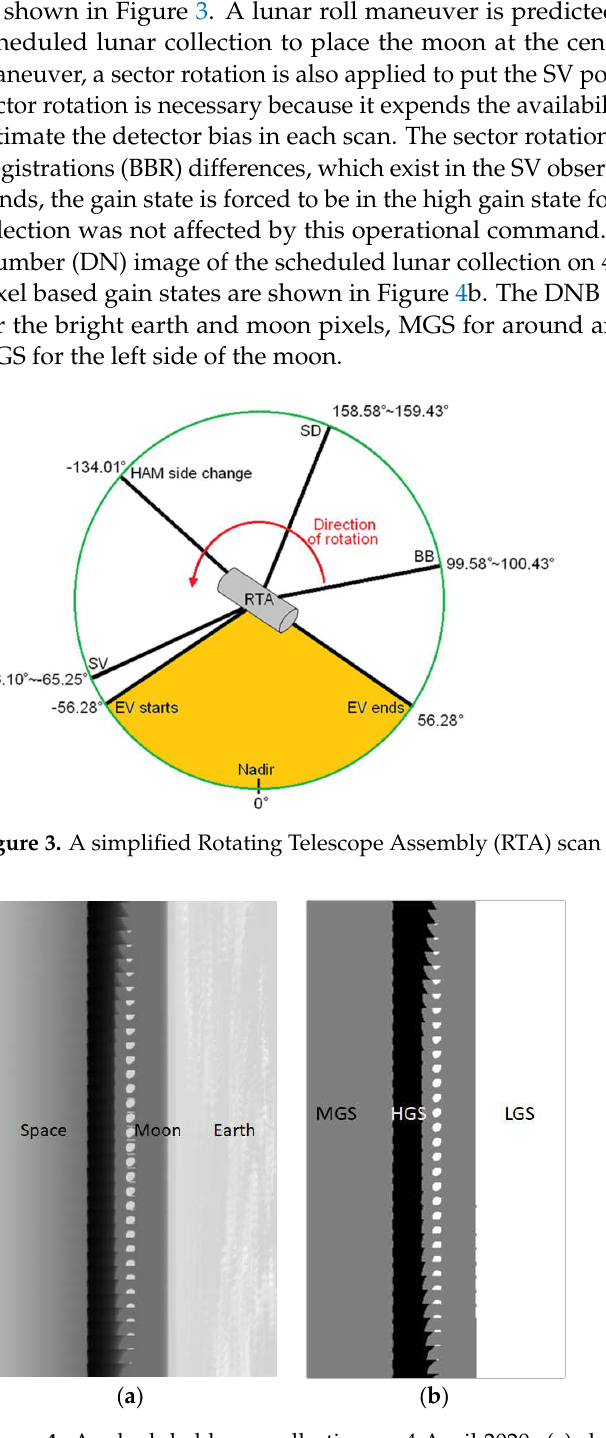
Figure 4. A scheduled lunar collection on April 4, 2020. ( a ) shows the raw Digital Number (DN) image and ( b ) shows the pixel gain states selected by the on-board DNB processor. The black, gray, and white areas represent HGS, MGS, and LGS, respectively.